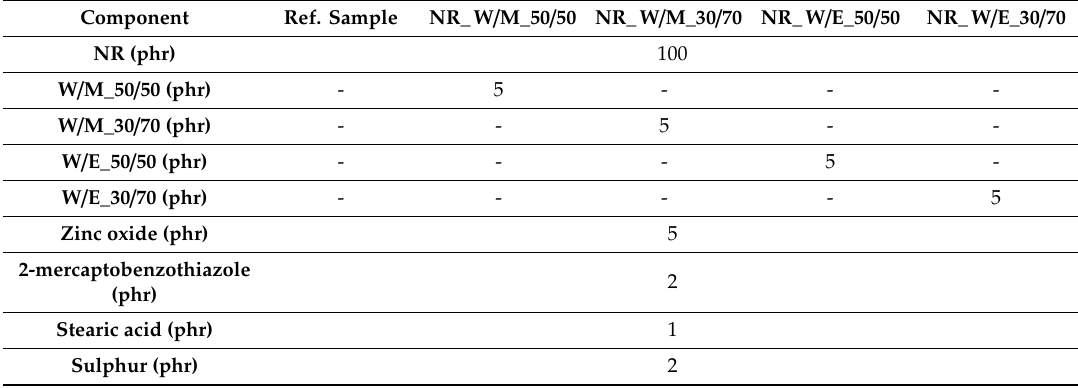
Table 1. Formulations of rubber